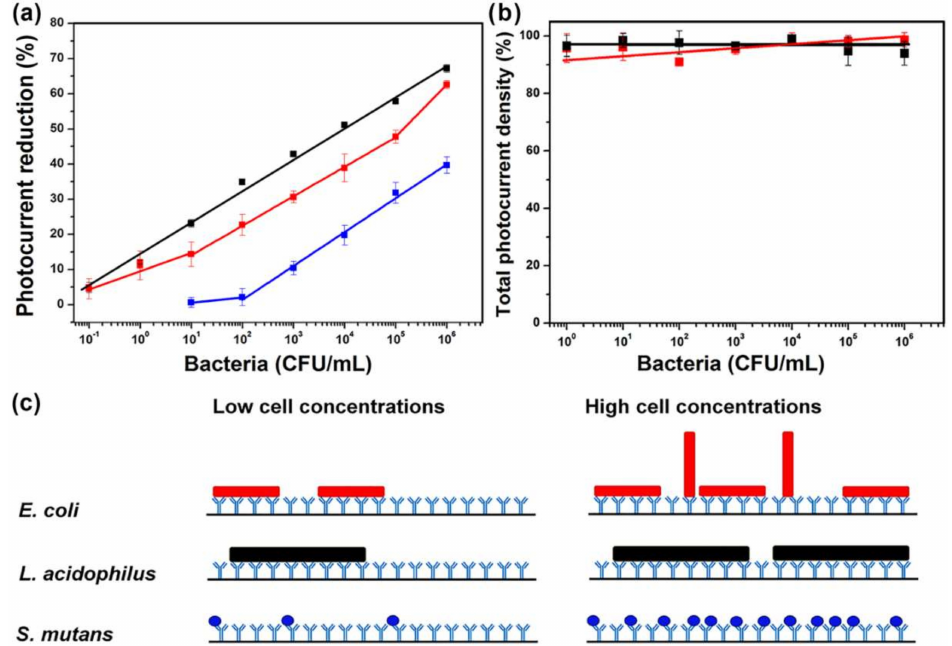
Figure 7. ( a ) Calibration curves of (red) E. coli , (black) L. acidophilus , and (blue) S. mutans immunosensing chips on the detection of E. coli K-12, L. acidophilus , and S. mutans cultures, respectively. ( b ) Relative total photocurrent densities of E. coli immunosensing chips on the detection of (red) B. subtilis and (black) L. acidophilus . The average of the total photocurrent densities generated by the fresh E. coli sensing chips incubated with only the blank cell-binding buffer was taken as 100% in ( b ). b-PM chips prepared via the complex linker and washed with a microfluidic flow were used to prepare all kinds of immunosensing chips. Bis(NHS)PEG2 was used for SpA conjugation. All of the data represent the average of three chips of a single kind with one standard deviation. ( c ) Schematic illustrating possible arrangements of different bacteria adsorbed on their respective immunosensing chips at low and high cell concentrations. For simplicity, the chips were represented with only their topmost antibody